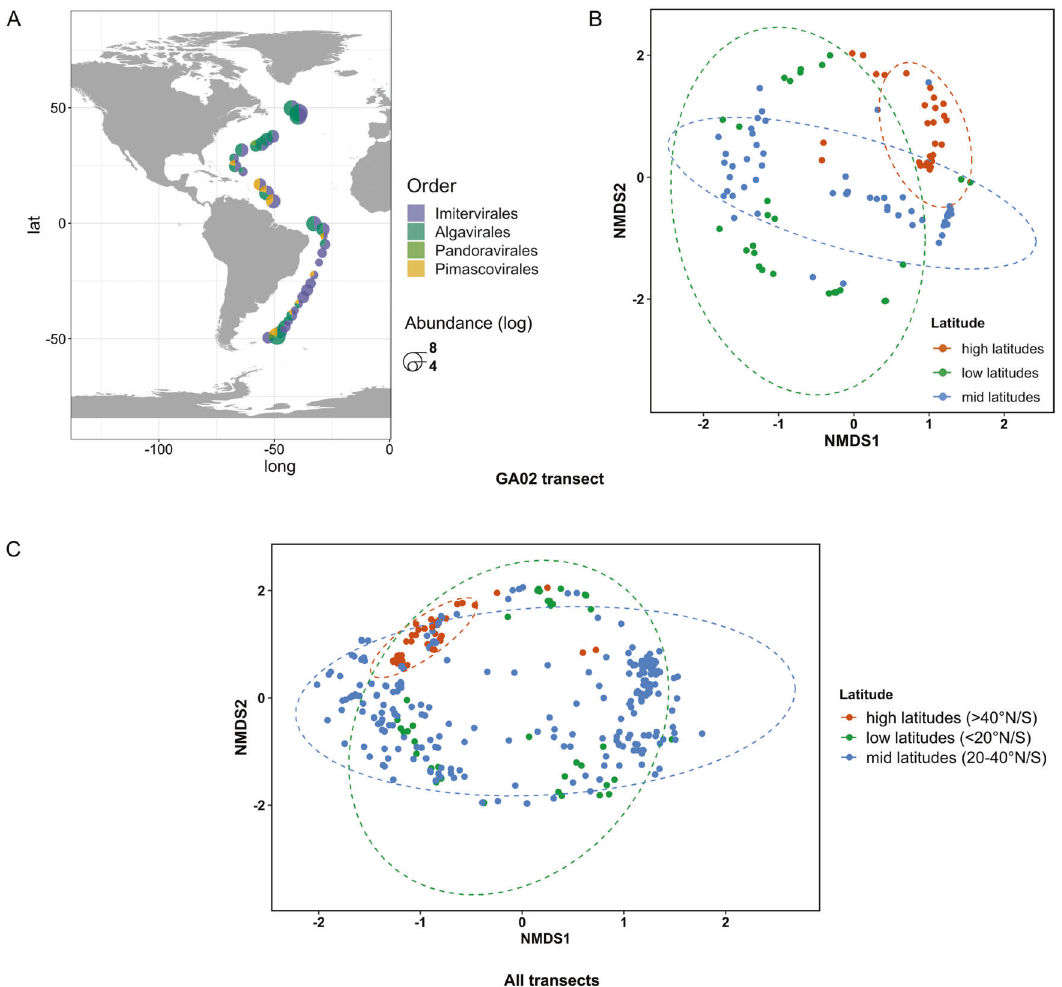
Fig. 7 Giant virus communities across latitudes. A Relative abundance of giant virus communities along the GA02 transect. Pie charts indicate the community composition in each sampling location, with sizes corresponding to the total abundance of the Nucleocytoviricota community. Community composition between latitudinal locations NMDS ordination based on Bray-Curtis distance matrices of viral communities collected in the ( B ) GA02 transect, stress = 0.3 ( C ) All four bioGEOTRACES, stress = 0.3. Latitudinal groups are color-coded by sample locations at higher than 40°N/S, from 20° to 40°N/S, and below 20°N/S (equatorial). Ellipses represent 95% con fi dence intervals. Viral communities are signi fi cantly different between groups (Permanova p <